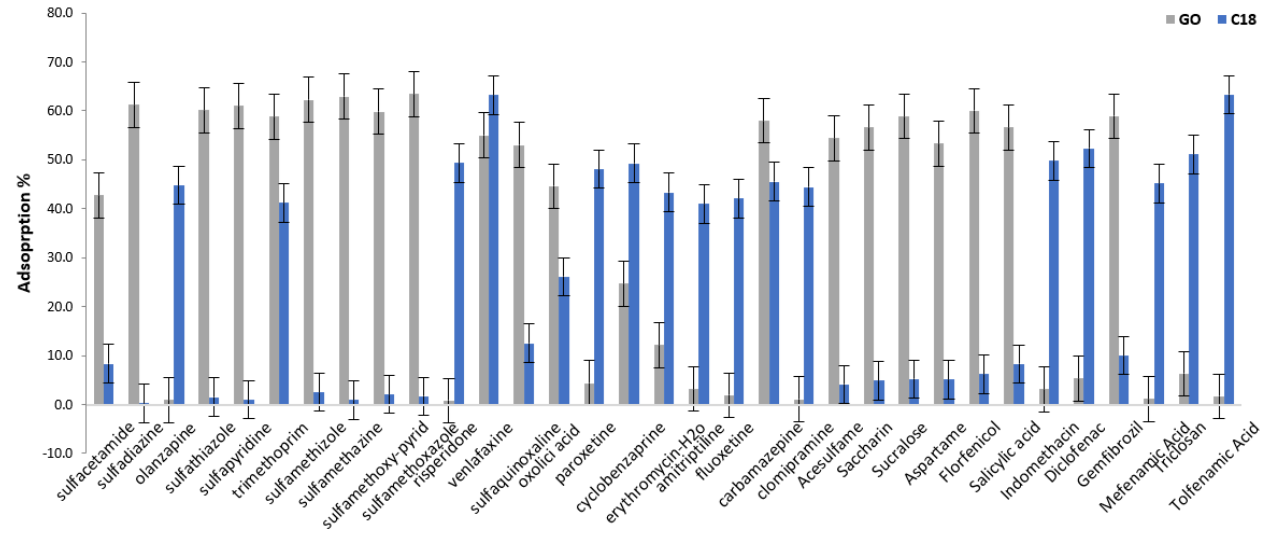
Figure 4. Sorption of target analytes in Fe 3 O 4 @GO (GO) and Fe 3 O 4 @SiO 2 @C18 (C18).